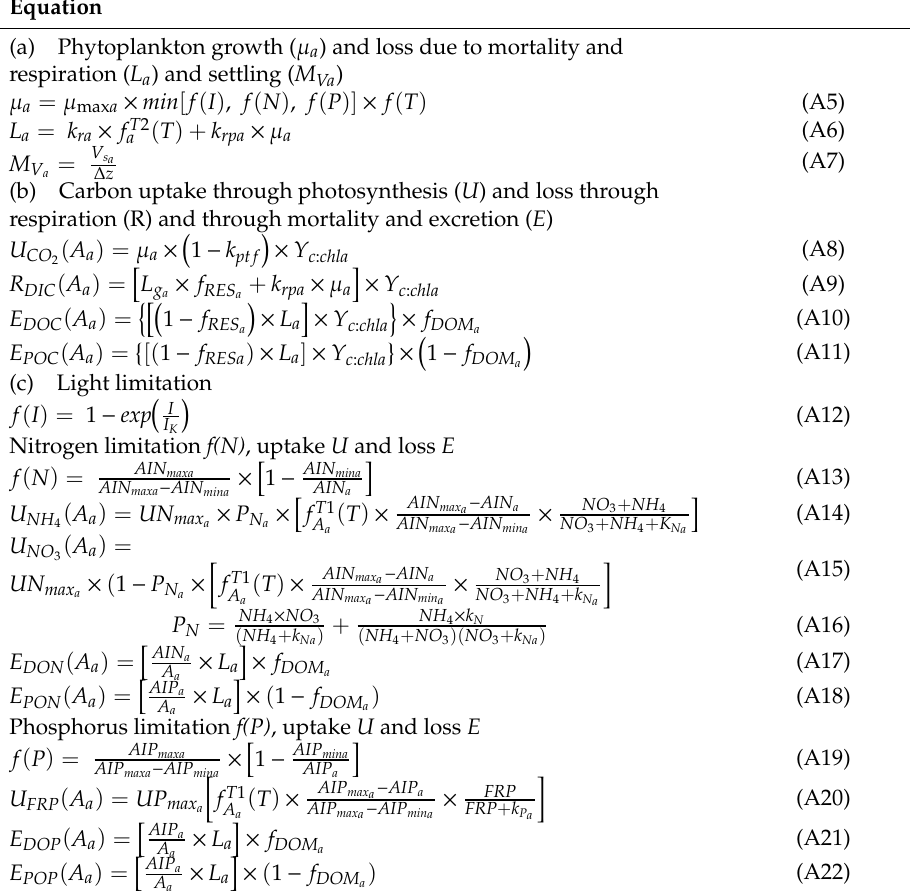
Table A3. Equations of phytoplankton modelling in CAEDYM. a is related to phytoplankton group.